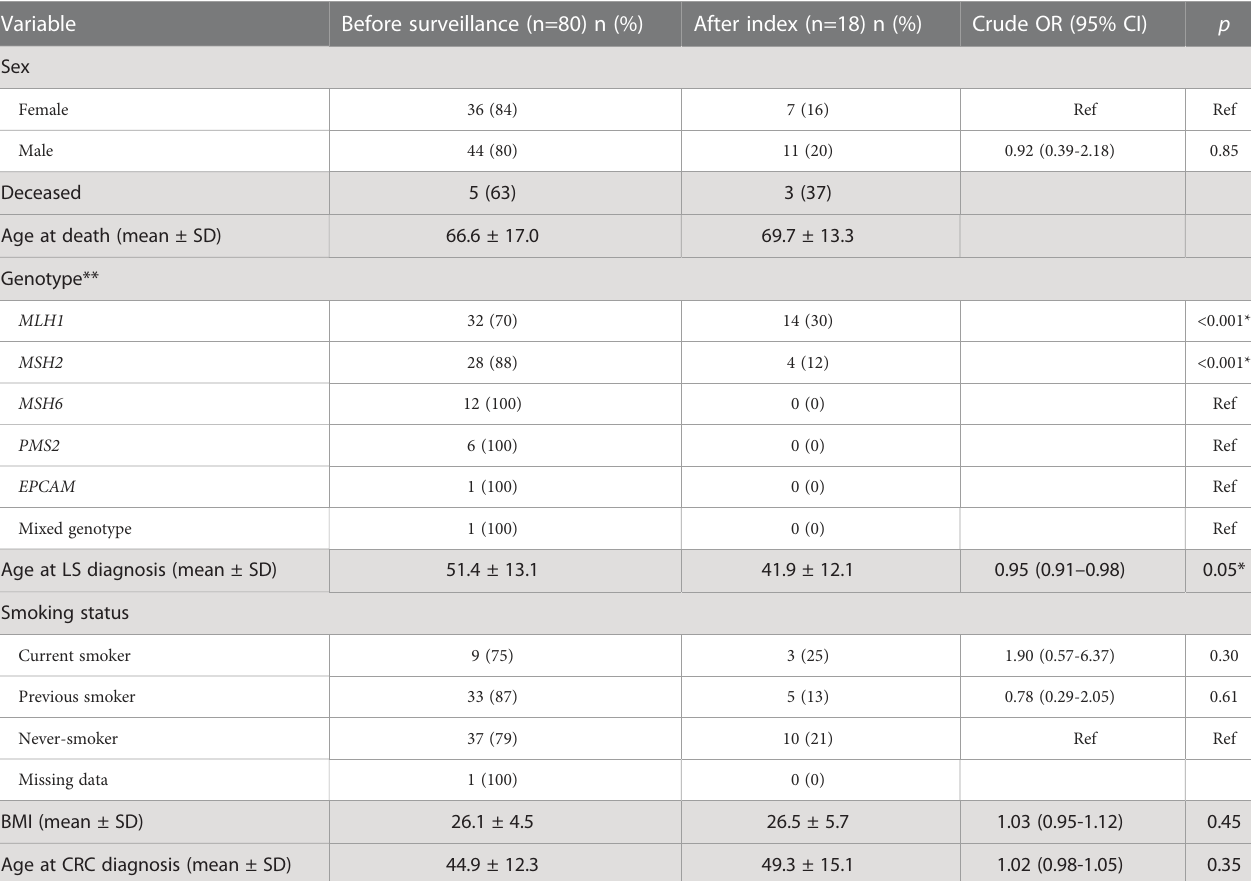
TABLE 3B Univariable logistic regression and Fisher ’ s exact test on patient characteristics of CRC cohort before surveillance and after index. Variable